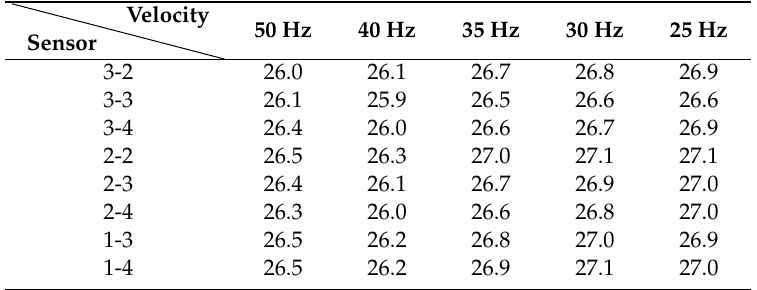
Table 10. Di ff erent supply air velocities and indoor temperatures at 1.1 m.